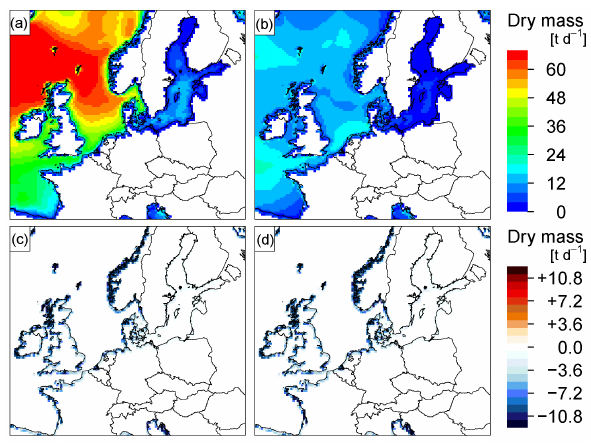
Figure 3. Average total sea salt emissions in t/d of the base case (top row) in winter 2008 (a) and summer 2008 (b) . The difference to the noSurf case (noSurf – base) is shown in the bottom row (c, d)